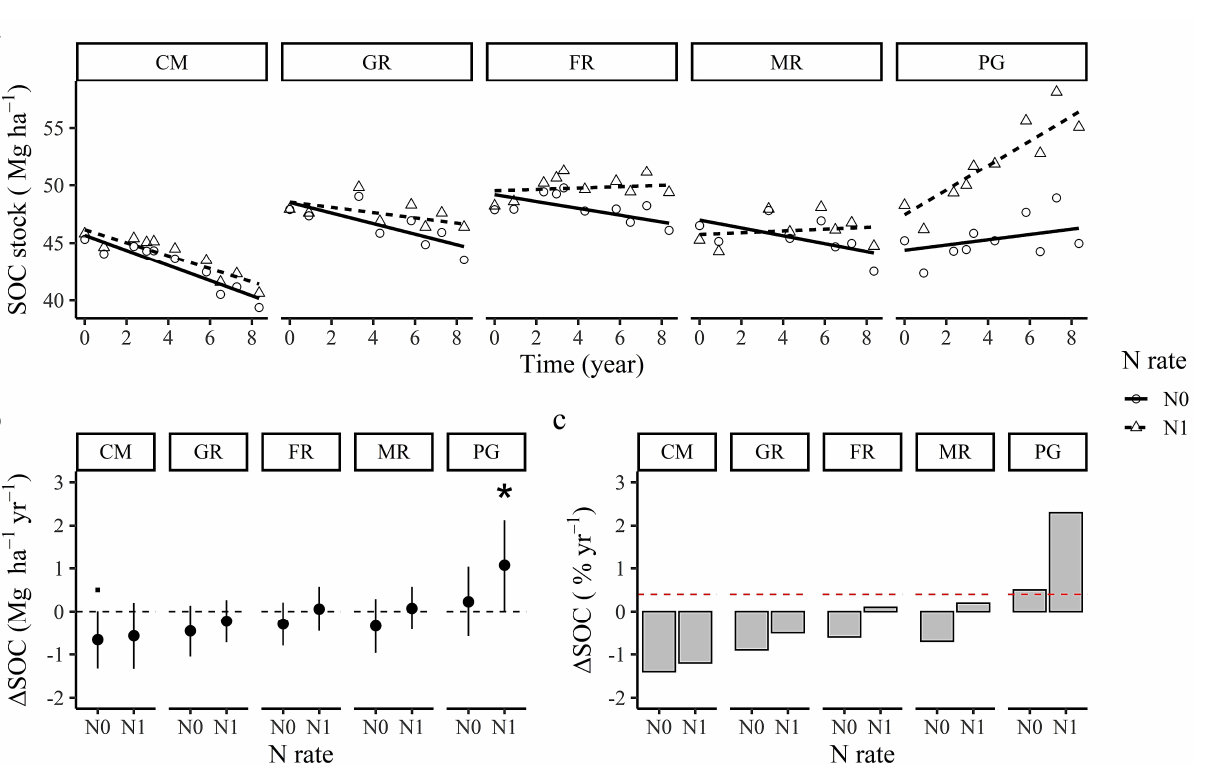
Figure 2. ( a ) Mean SOC stocks, ( b ) mean annual SOC change rates ( ∆ SOC) ( ± 95% confidence intervals) (Mg ha − 1 yr − 1 ), and ( c ) mean relative change (%) of the different cropping systems and N fertilization rates related to the initial SOC stock of 2010 (zero value) and to the target value of 0.4% (dotted red line), measured from autumn 2010 to spring 2019. Cropping Systems (CS) are ordered from smallest to largest annual SOC changes ( ∆ SOC). Significance at p ≤ 0.1, p ≤ 0.05 are indicated by ▪ , *, respectively. CM: continuous silage maize, GR: grain rotation, FR: forage rotation, MR: